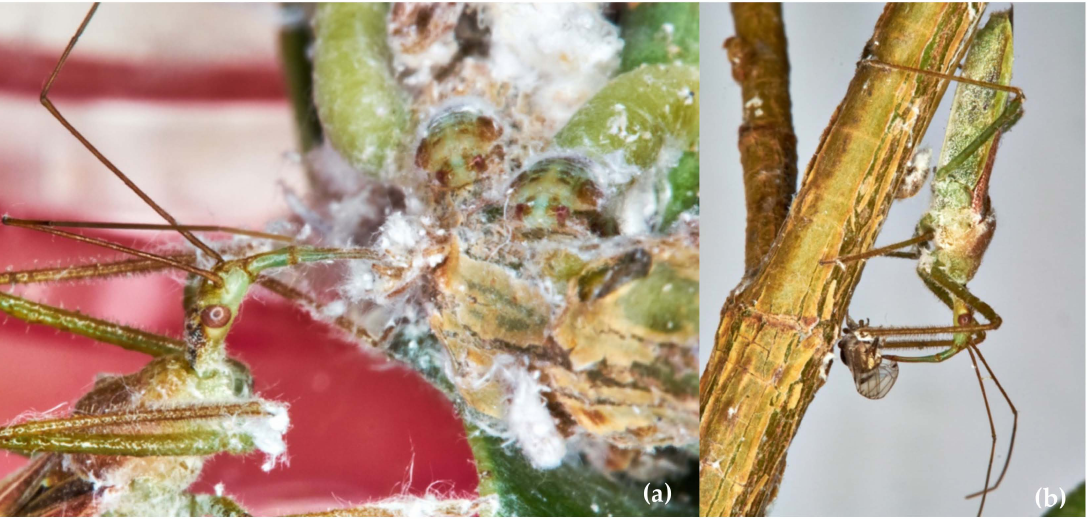
Figure 9. ( a ) LAB female feeding on Macrohomotoma gladiata juvenile; ( b ) LAB female feeding on M. gladiata